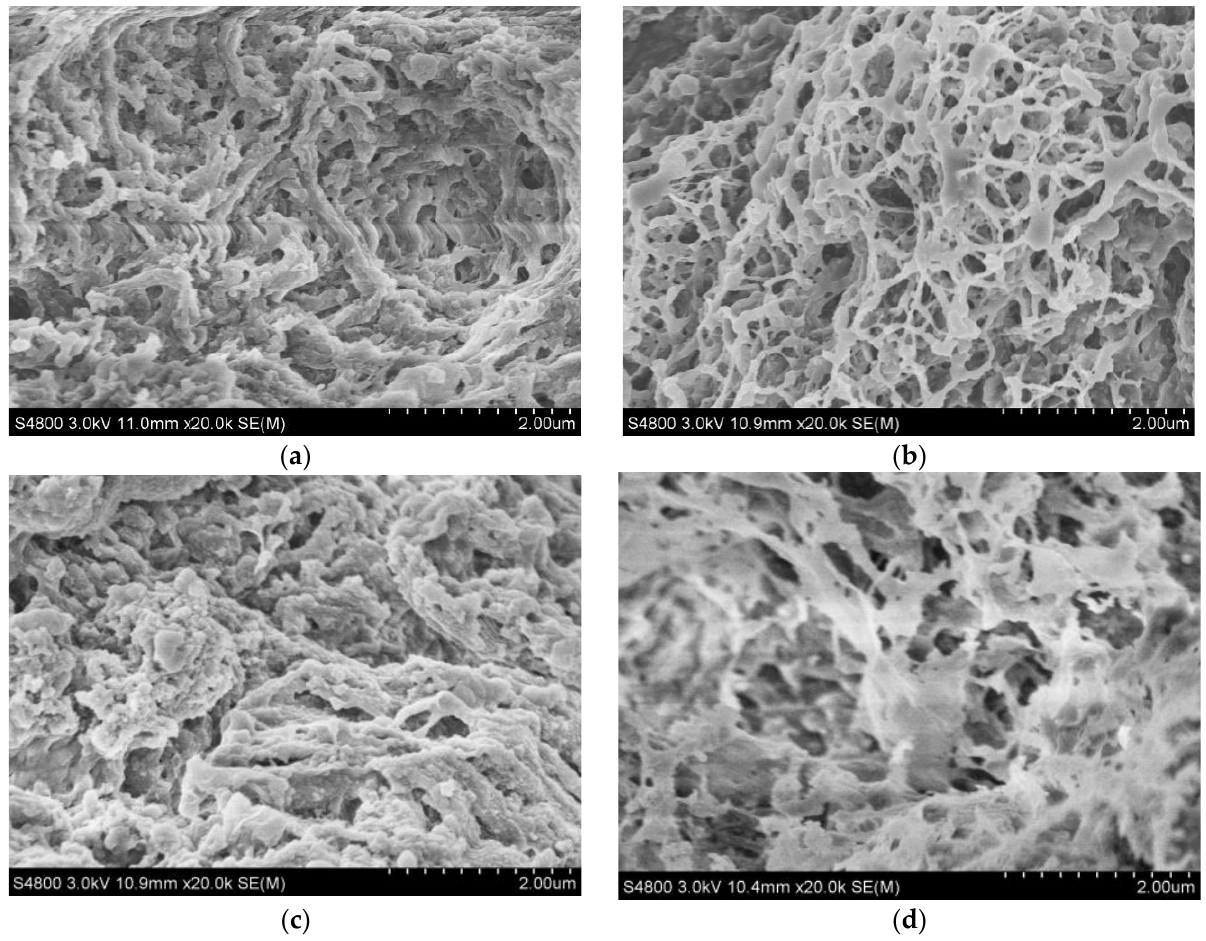
Figure 5. Fiber diagrams of interface adductor muscle under different experimental conditions. ( a ) Untreated; ( b ) 100 MPa; ( c ) 200 MPa; ( d ) 300 MPa.